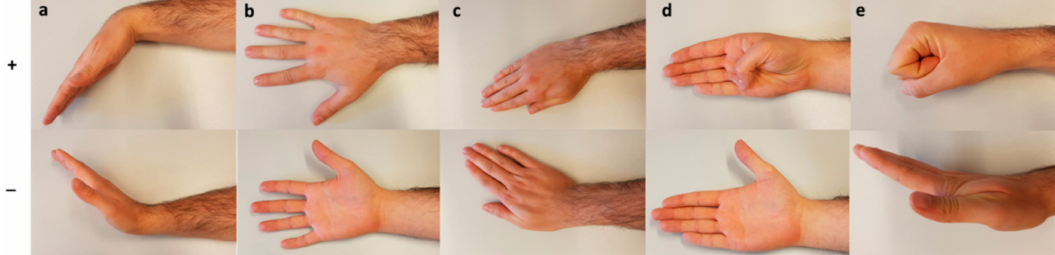
Figure 2. Representation of one trial of each movement the participants need to perform. All movements start at the neutral position. The movements are: ( a ) flexion and extension of the wrist; ( b ) radial and ulnar deviation of the wrist; ( c ) pronation and supination of the wrist; ( d ) flexion and extension of the MCP and IP joints of the thumb; and ( e ) flexion and extension of the MCP, PIP and DIP joints of the four